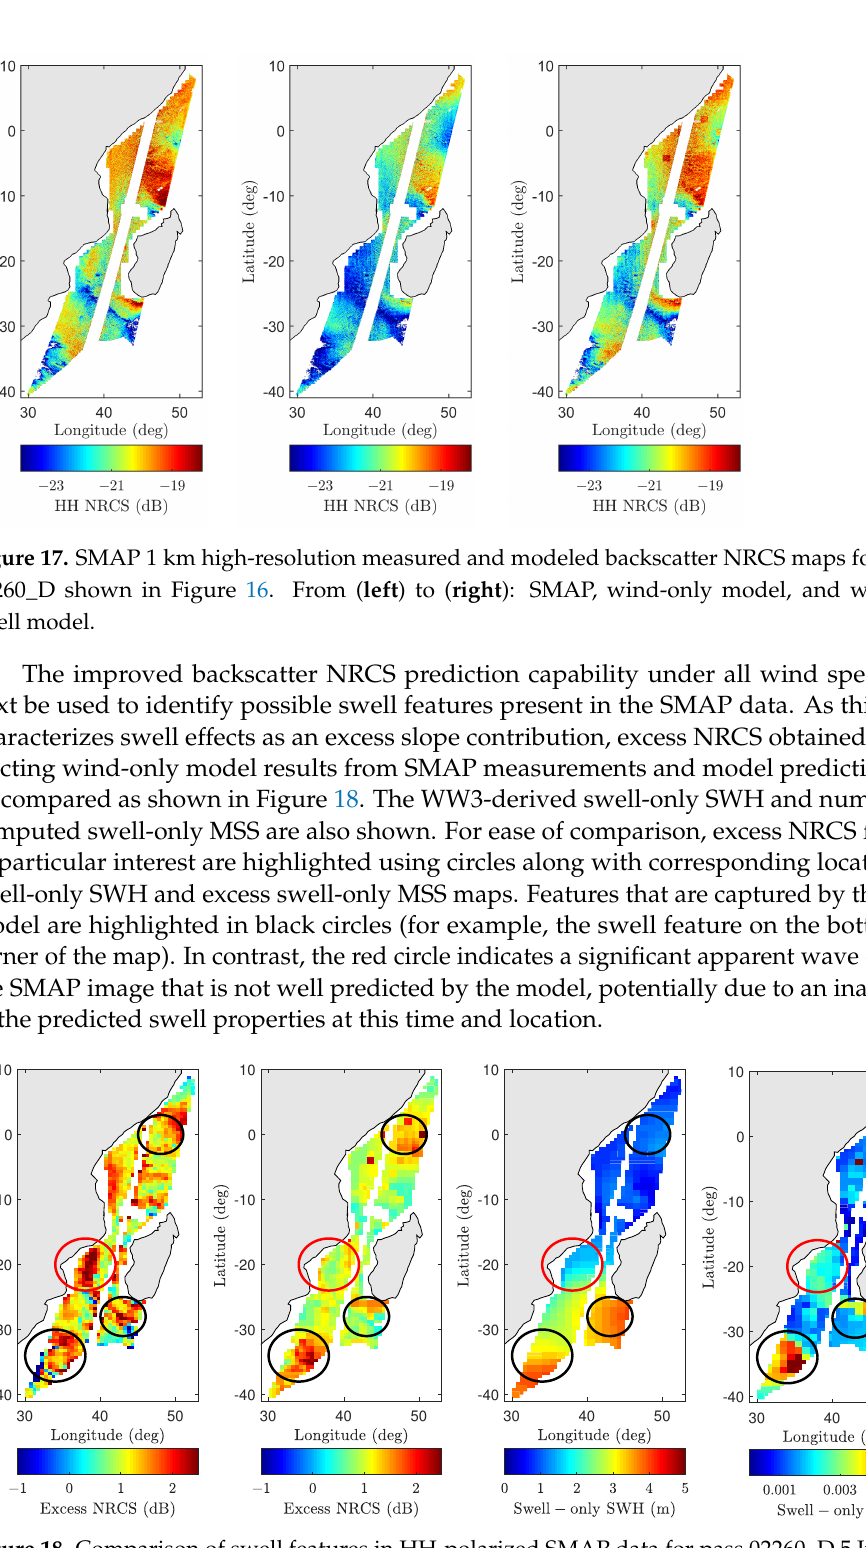
Figure 18. Comparison of swell features in HH-polarized SMAP data for pass 02260_D 5 July 2015, at 02:32:47 UTC. Plots from ( left ) to ( right ) show excess SMAP NRCS (SMAP-TSM (W)), excess model NRCS (TSM (W+S)-TSM (W)), WW3 swell-only SWH, and swell-only MSS derived from approximated 2D spectra based on WW3 partitioned data,